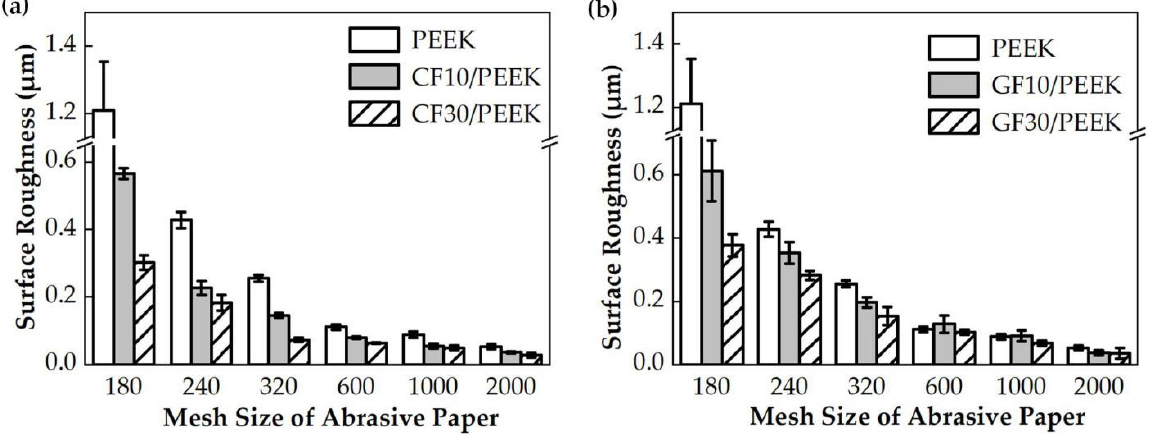
Figure 7. Comparative analysis on surface roughness of the fiber mass fraction: ( a ) The surface roughness of the pure PEEK, CF10/PEEK, and CF30/PEEK, ( b ) the surface roughness of the pure PEEK, GF10/PEEK, and GF30/PEEK.